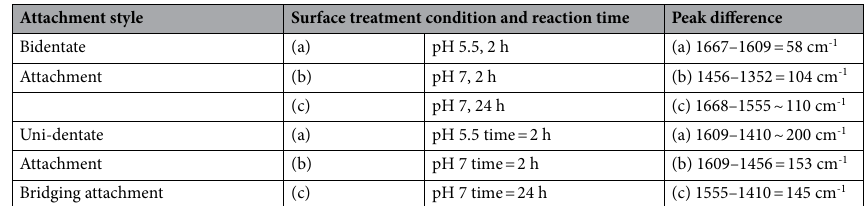
Table 3. Surface modification of CuONPs using BA, using different conditions, and the FTIR peak differences. First column listed the predicated attachment chemical structures under different conditions and 3 types of peaks difference achieved providing details for the BA attachment structures.